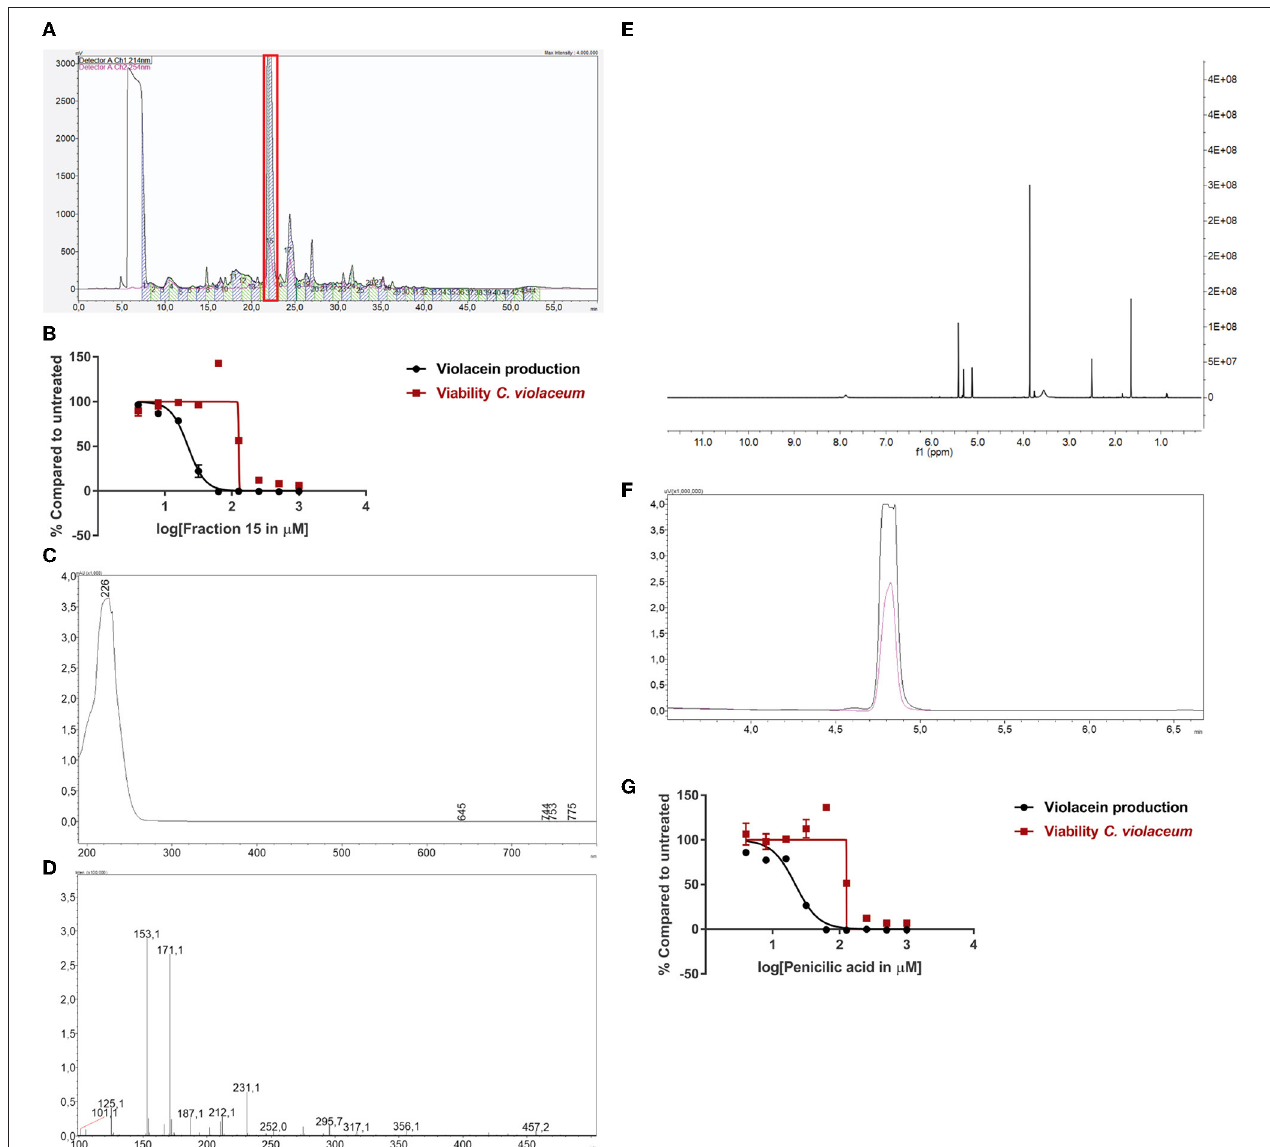
FIGURE 3 | Identification of penicillic acid as QS inhibitor. (A) After growing Penicillium simplicissimum in large volume, the extract was fractionated using prep-HPLC. Fraction 15 (red box) was the active fraction. (B) QS inhibitory activity of fraction 15 using C. violaceum as a reporter (black line and symbols) and cell viability in parallel (red line and symbols). A range of concentrations was tested. (C) UV-VIS spectrum of fraction 15. (D) LC/MS analysis of fraction 15. (E) 1 H-NMR of fraction 15. (F) Analytical HPLC chromatogram of fraction 15 (black line) compared to commercial penicillic acid (pink line), showing a similar retention time. (G) QS inhibitor activity and viability of commercial penicillic acid. Experiments were done in triplicate. Error bars represent